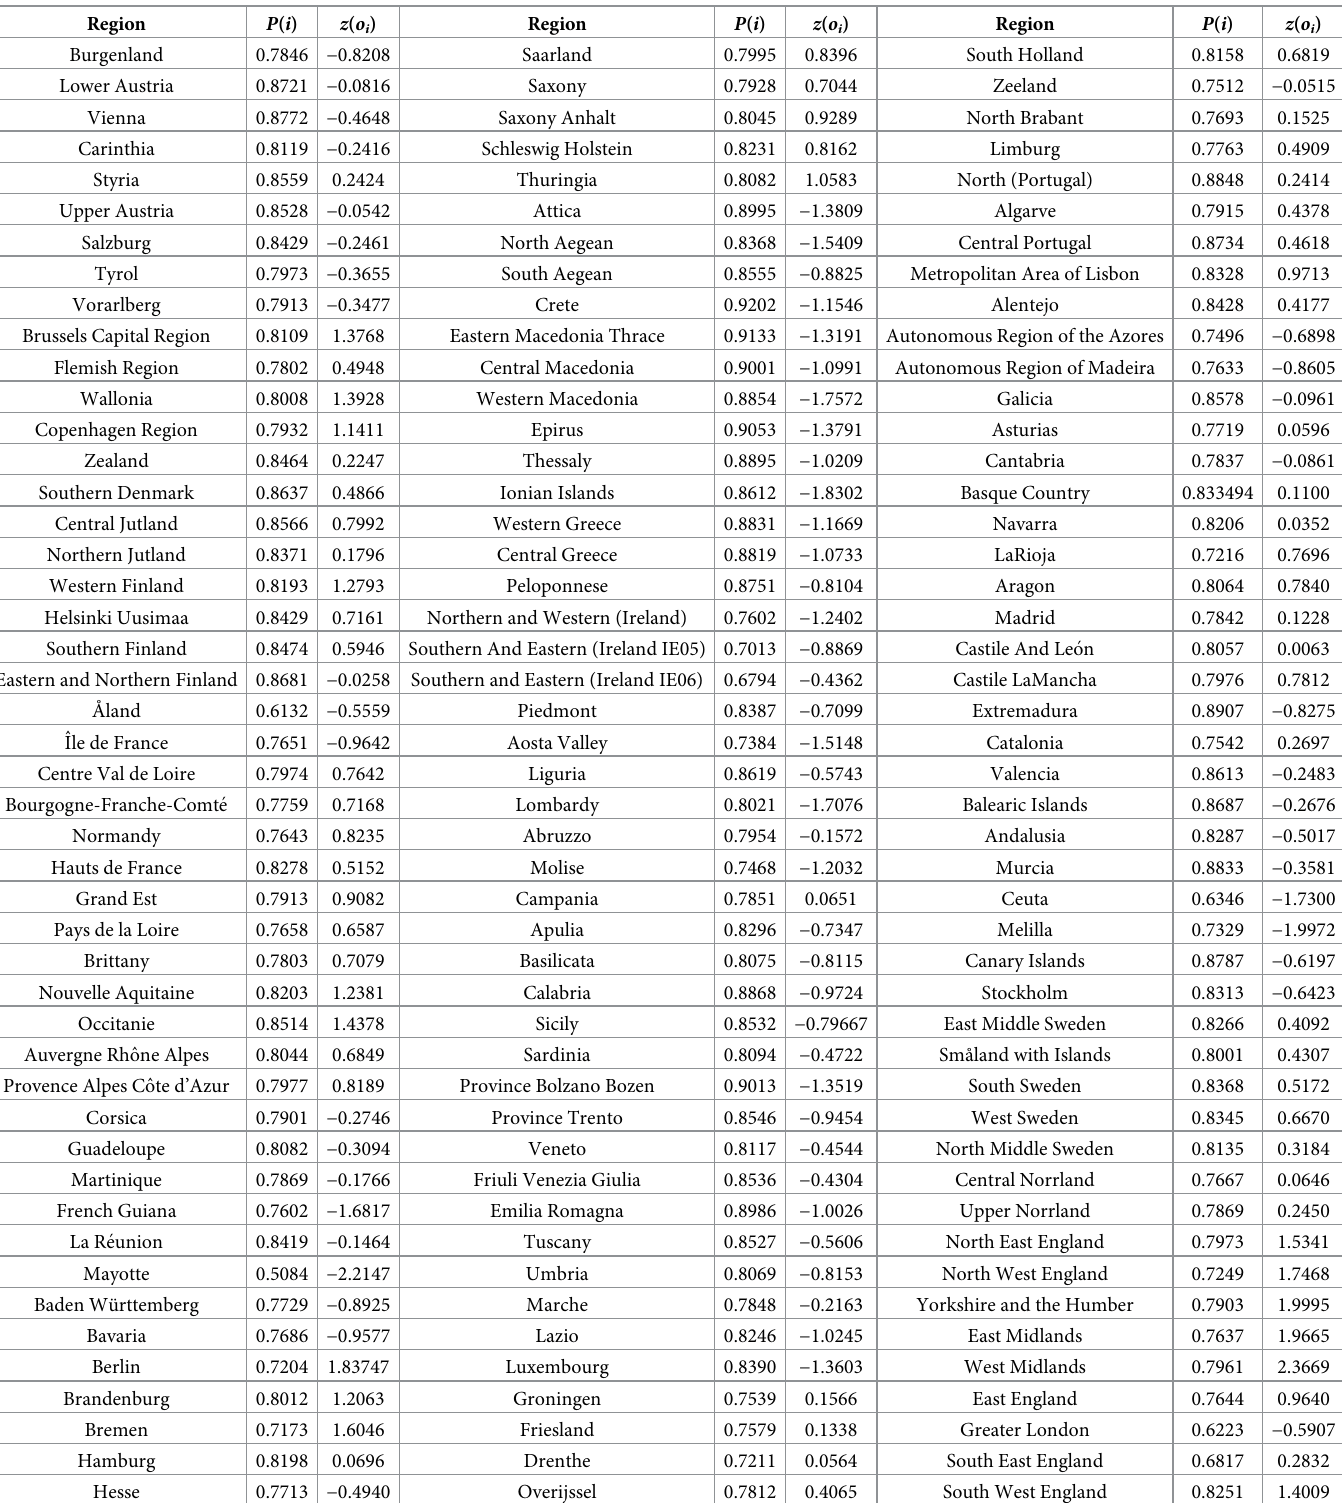
Table 9. Multiplex participation coefficient P ( i ) with Z -scores (WE